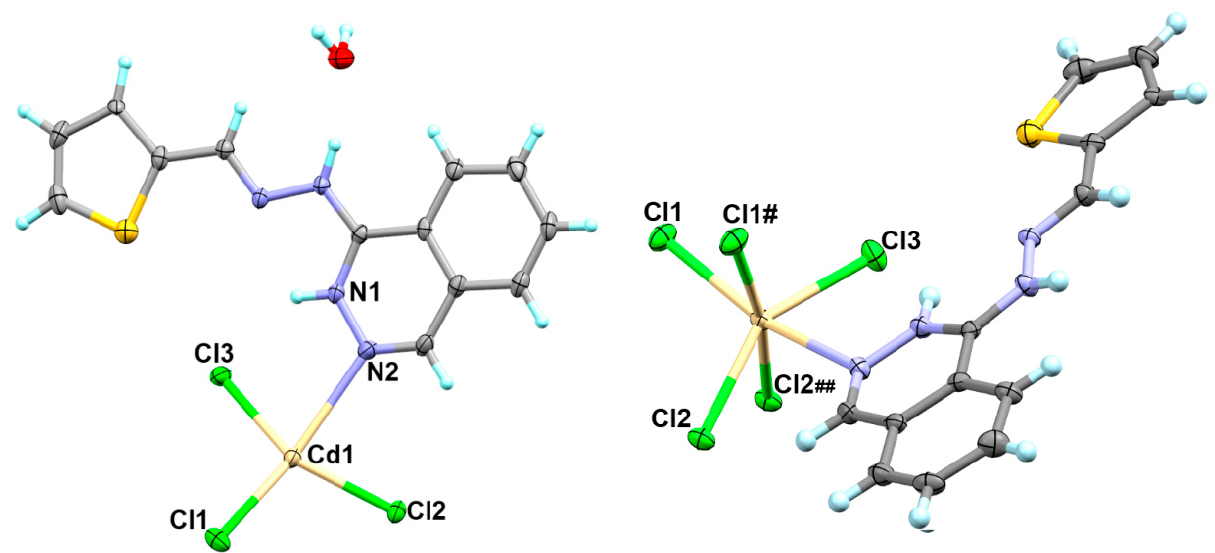
Figure 3. Asymmetric unit ( left ) and coordination sphere ( right ) with atom numbering for 1 . In this complex, the central metal ion could be described as hexa-coordinated with one H 2 L + , one terminal chloride (Cl3) and four bridging chloride ions (Cl1 and Cl2). Each two symmetrically related bridged chloride ions are related to one another by an inversion center; hence the asymmetric unit comprised only three chloride ions. The complete coordination sphere of this complex is shown in Figure 3 (right part) while the list of bond distances and angles are given in Table 2. It is clear that the terminal Cd1-Cl3 bond is the shortest (2.497(1) Å) among the other Cd-Cl interactions. The other chloride anions (Cl1 and Cl2) connecting the Cd1 centers with inequivalent Cd-Cl distances for each. The symmetrically related chloride ions are located cis to each other and found coordinated with the Cd1 with one short and one long Cd-Cl bonds. The Cd1-Cl1 and Cd1-Cl1# distances are 2.563(1) and 2.677(1) Å, respectively while the corresponding Cd1-Cl2 and Cd1-Cl2## distances are 2.517 and 2.858 Å, respectively. The coordination geometry around Cd1 could be described as a highly distorted octahedral with continuous shape measurements of 4.35 and 7.79 compared to the perfect octahedron and trigonal prism, respectively [69–72]. Table 2. Bond distances (Å) and angles ( ◦ ) for 1 . Atoms Distance Atoms